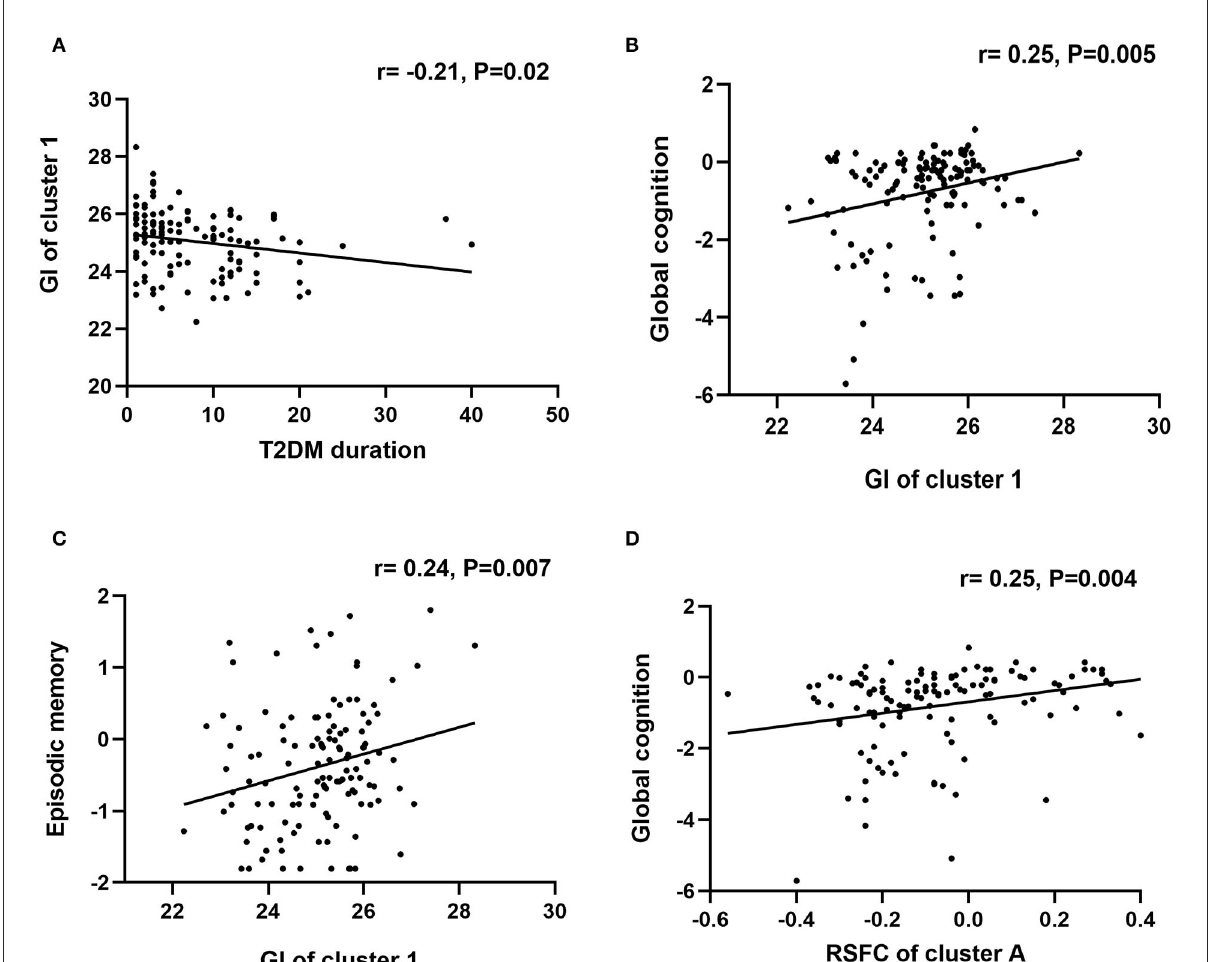
FIGURE3 Correlational analysis in the T2DM-MCI group. (A) Correlation analysis between T2DM duration and GI of cluster 1. (B) Correlation analysis between GI of cluster 1 and global cognition. (C) Correlation analysis between GI of cluster 1 and episodic memory. (D) Correlation analysis between RSFC of cluster A and global